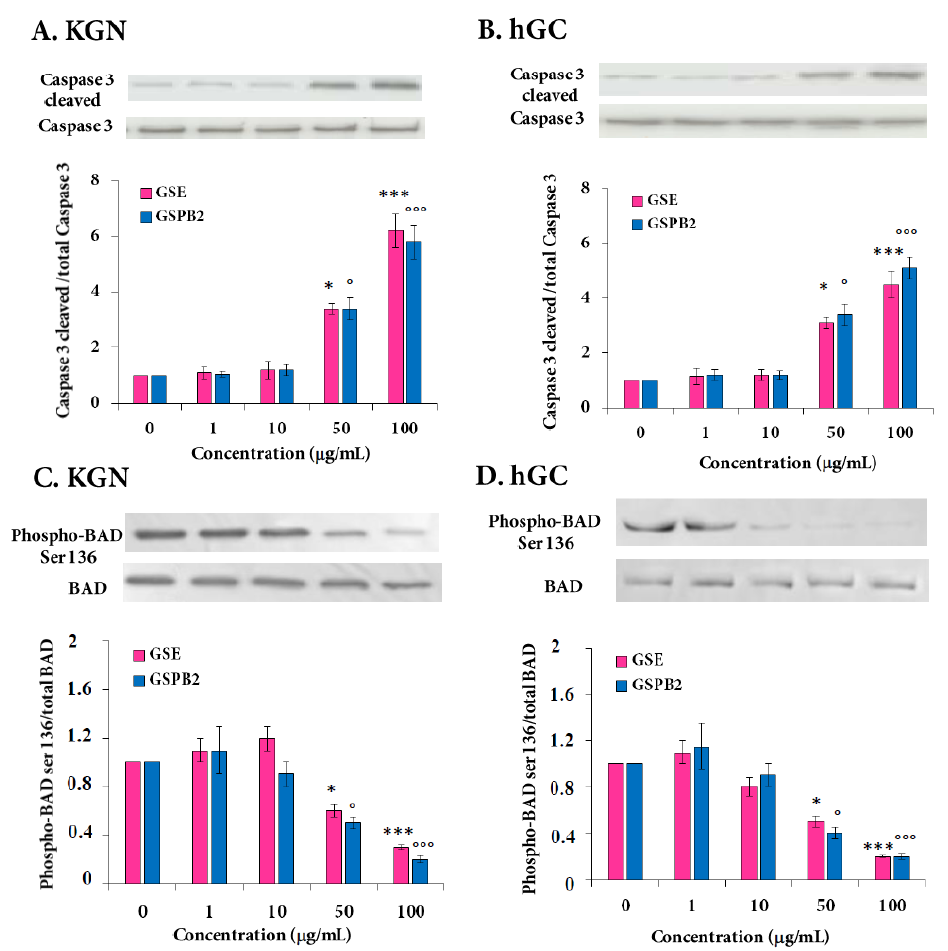
Figure 4. E ff ect of the GSE and GSPB2 treatments on the protein levels of cleaved-caspase-3 ( A , B ) and phosphorylation levels of Bcl-2-associated death promoter (BAD) ( C , D ) in human granulosa cells. KGN ( A , C ) and hGC ( B , D ) cells were plated and incubated in various concentrations of GSE and GSPB2 (0, 1, 10, 50, and 100 µ g / mL) for 24 h in appropriate medium with serum. Then, cells were lysed and proteins were separated by SDS-PAGE. The levels of Ser cleaved-caspase-3 and total caspase-3 ( A , B ), 136-phosphorylated BAD and BAD ( C , D ), were analyzed by probing with the appropriate antibodies as described in Materials and Methods. Representative blots in response to di ff erent concentrations of GSE are shown. The results are means ± SEM of four independent cultures with each condition in quadruplet. For hGC cells, an independent culture was from a pool of cells collected from three patients. * and *** represent a significant e ff ect of GSE as compared to the control at p ≤ 0.05 and p ≤ 0.001, respectively. ◦ and ◦◦◦ represent a significant e ff ect of GSPB2 as compared to the control at p ≤ 0.05 and p ≤ 0.001,